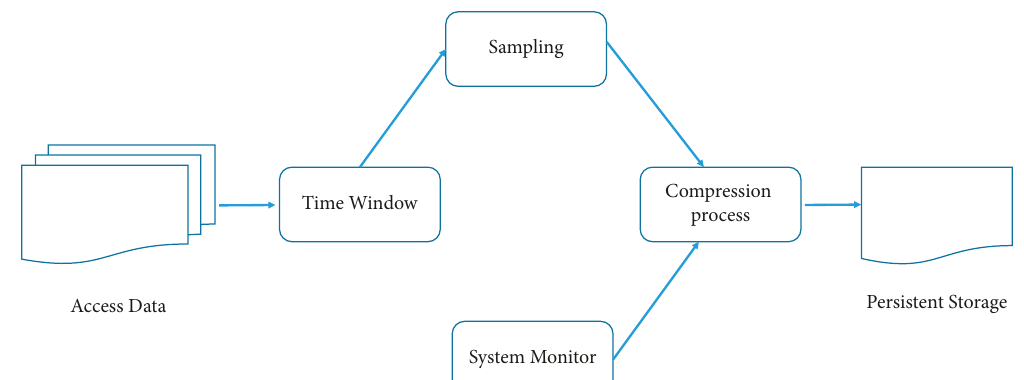
Figure 2: Schematic design of data compression